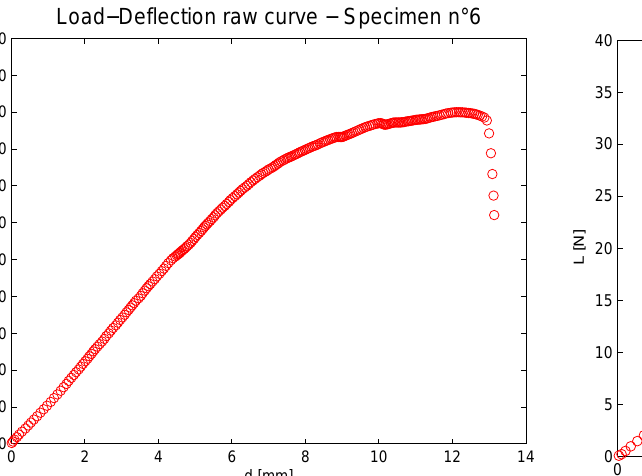
Figure 8: Raw load-deflection curve for specimen